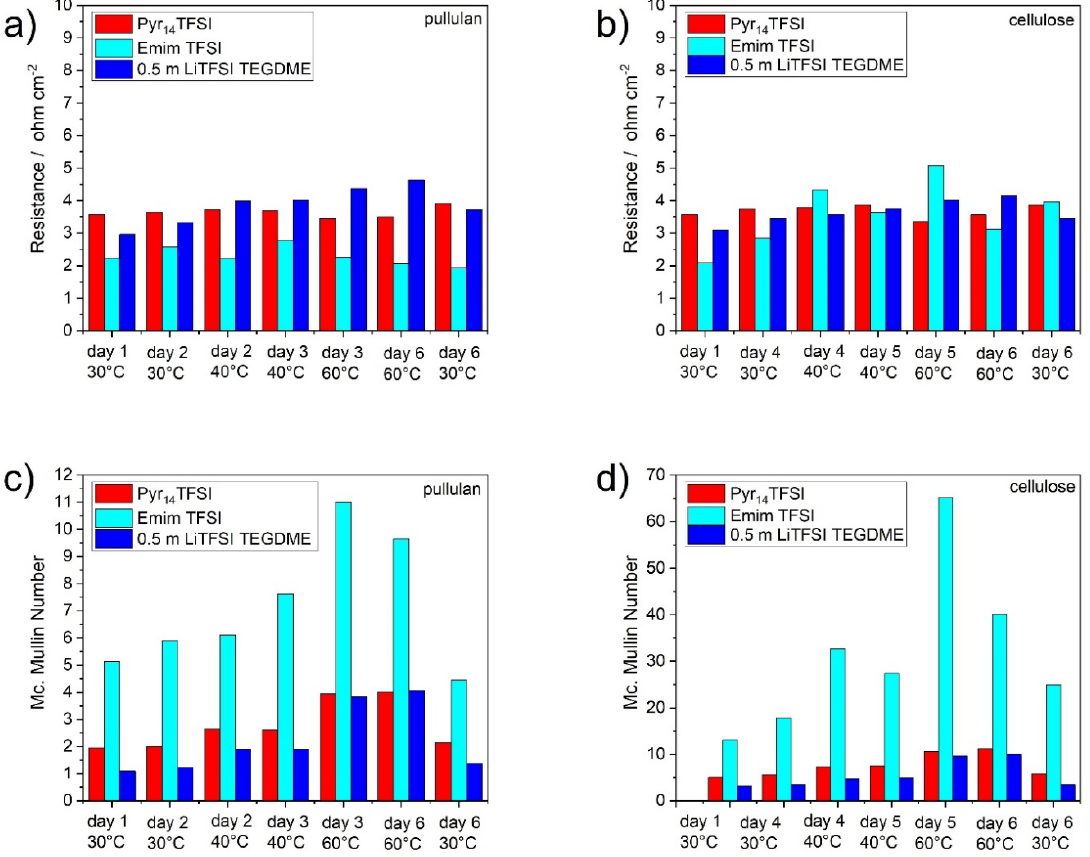
Figure 3. Resistance normalized by the plain area and MacMullin number of ( a , c ) Pullulan and ( b , d ) Cellulose triacetate electrospun separators in different tested electrolytes.